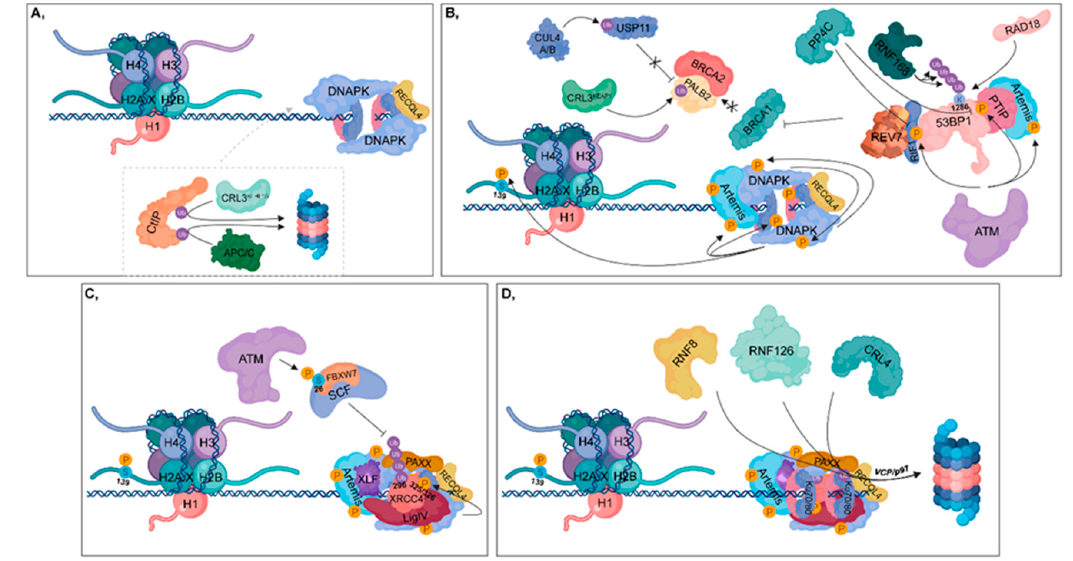
Figure 3. Non-homologous end joining (NHEJ). ( A ) During the G1 phase, CtIP is ubiquitylated